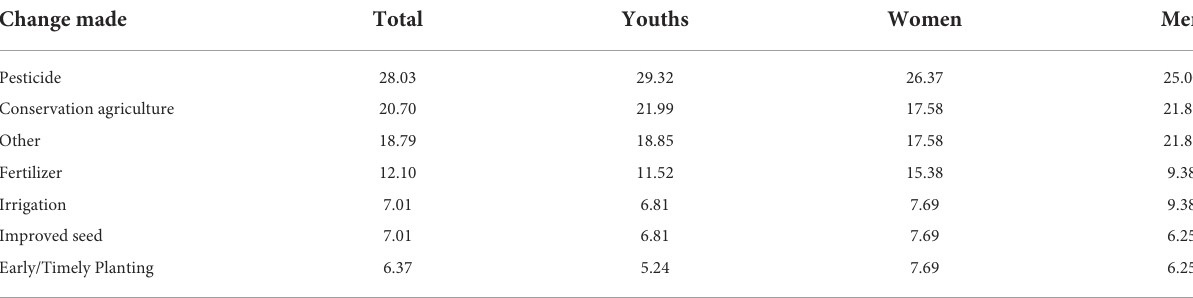
TABLE 4 Changes made in response to common bean production constraints by gender. Change